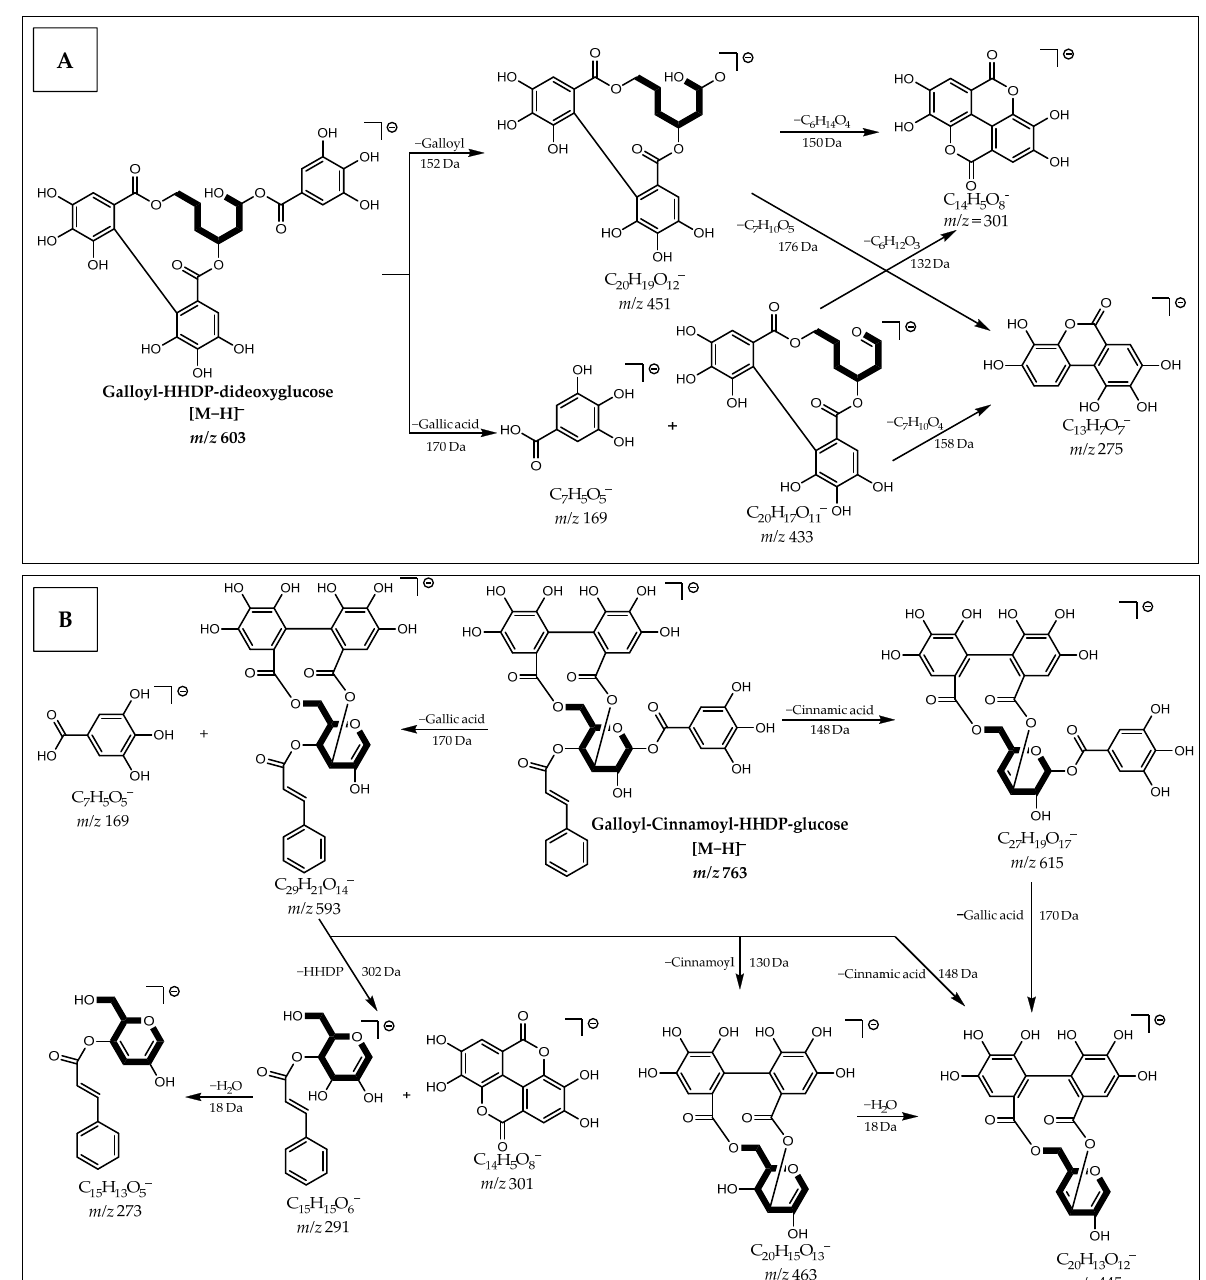
Figure 3. Proposal for fragmentation of: ( A ) Galloyl-HHDP-dideoxyglucose; ( B ) Galloyl-Cinnamoyl-HHDP-glucose.